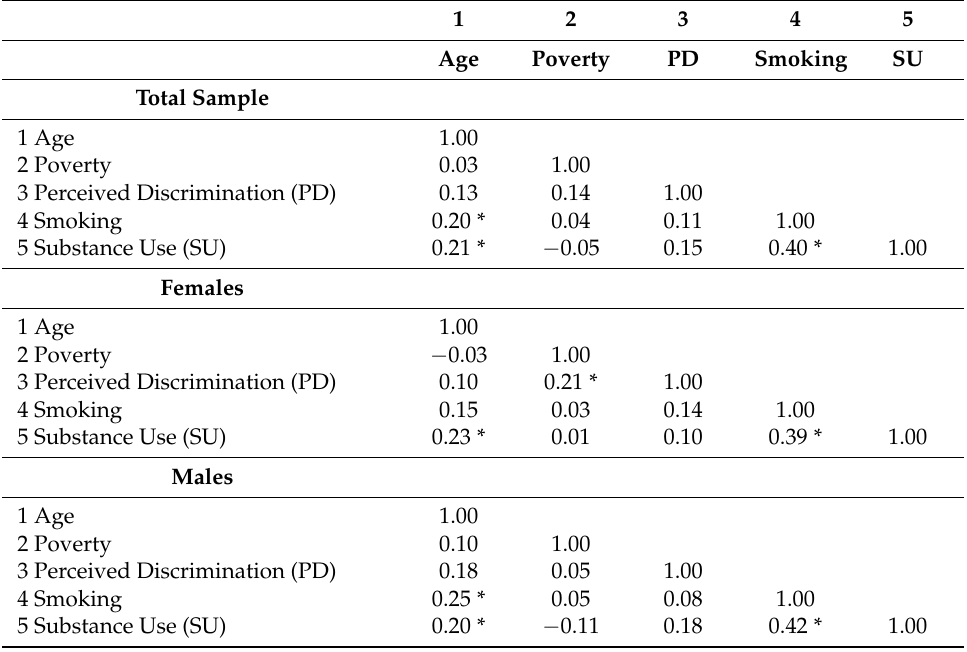
Table 2. Correlations matrix between the study variables among Caribbean Black youth overall and by gender